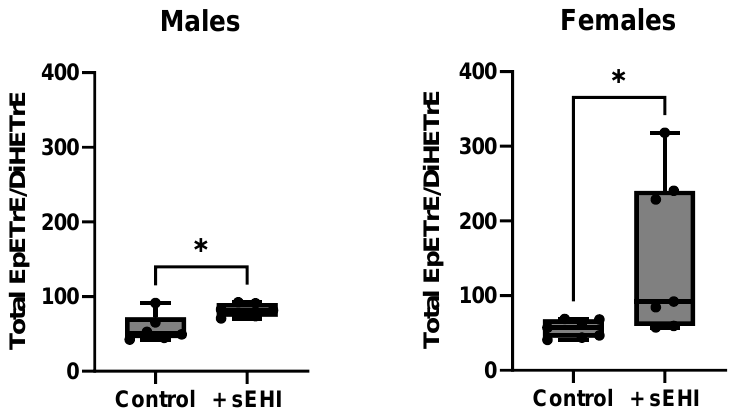
Figure 2. Total EpETrE/DiHETrE ratios of brain free oxylipin contents in males and females. The box extends from the 25th to the 75th percentile, with the middle line indicating the median. The whiskers extend to the minimum and maximum values, with individual values indicated by black dots. For definitions of oxylipin abbreviations see Table S1. * p < 0.05. Body weight did not differ between mice in the sEHI-treated and control groups in both males and females (Table 1). Fasting levels of serum insulin, glucose, and cholesterol did not differ between sEHI-treated and control mice in either sex (Table 1). There were no differences between the sEHI-treated and control females in estrus cycle phase (data not shown). Table 1. Bodyweight and serum analytes. Males Females Control + sEHI Control + sEHI Bodyweight (g) 36.19 ± 6.183 36.46 ± 5.384 29.20 ± 4.940